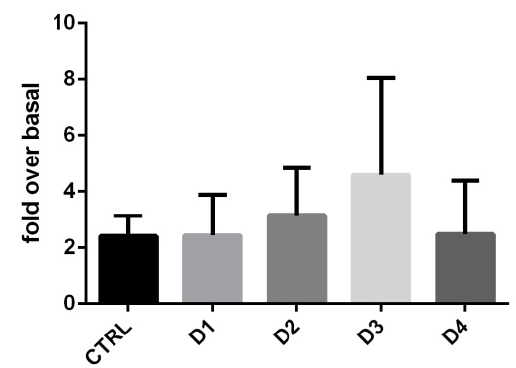
Figure 4. Number of BFP-MSCs harvested from disks and re-plated in 12-well culture plates for 72 h. Bars represent the number of live cells relative to those plated upon detachment from disks.